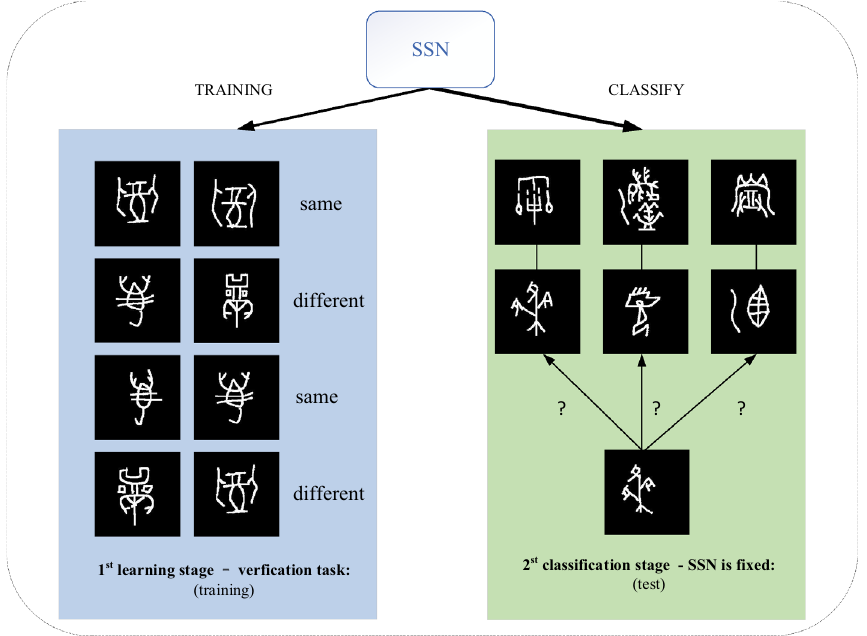
Figure 1. The general strategy. We adopt a two-stage end-to-end recognition framework. In the learning stage, a good representation of the SSN model is obtained through a series of verification tasks, and in the classification stage, the trained model is used to perform nearest neighbor